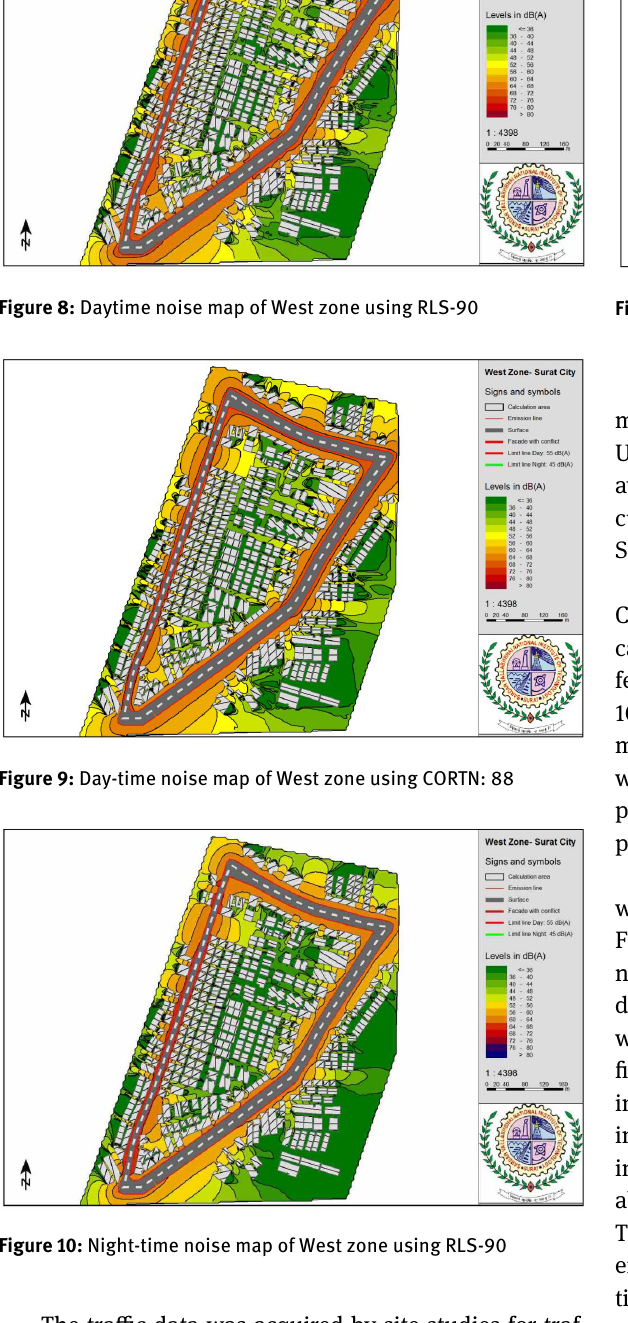
The traffic data was acquired by site studies for traf- fic counts. The speed of the vehicle was taken using the radar gun and the average values of speed observed were between 35-45 kmph. A further assumption in the compu- tation was that all road and motorway surfaces are con- structed of impervious bitumen and that all the measure- ment were taken only during i.e. Monday to Friday.